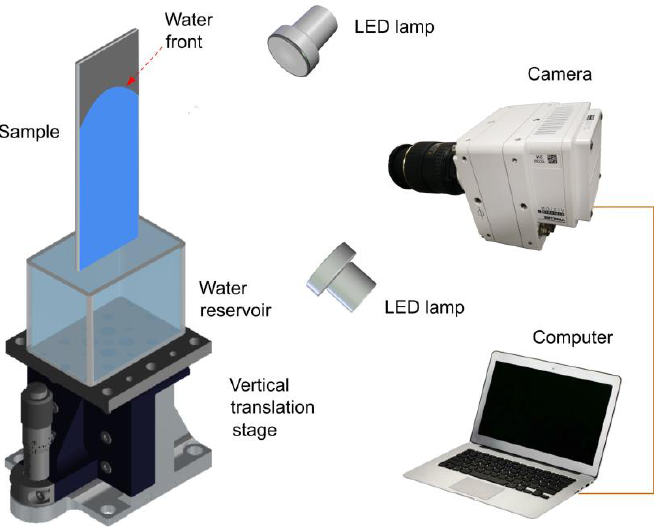
Figure 1. Experimental setup for high-speed video recording of capillary flow dynamics in static air at 23 °C.